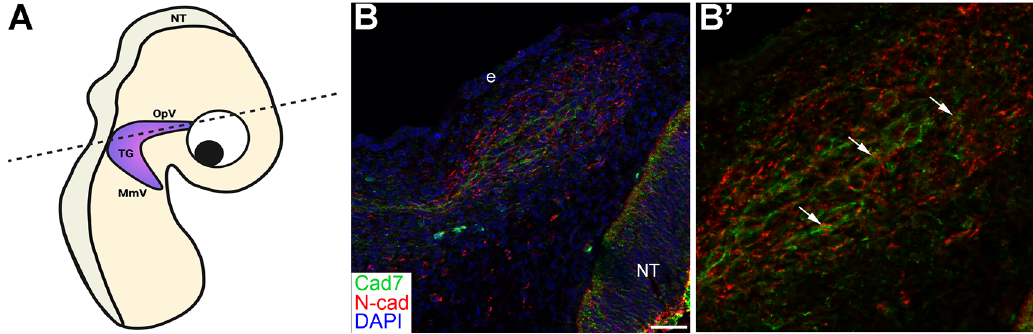
Figure 10. N-cadherin and Cadherin-7 are expressed in condensing placodal neurons and neural crest cells, respectively, during chick trigeminal ganglion assembly. (A) Cartoon diagram of forming TG in the developing chick embryo. Plane of section is shown by the dotted line. Diagram created with BioRender.com. (B) Representative transverse section taken through the forming TG followed by immunohistochemistry for Cad7 (green, marks neural crest cells) and N-cad (red, marks neurons which are all placode-derived at this stage). (C) Higher magnification (digital)oftheTGin(B).DAPI(blue),cellnuclei.Scalebarin(B)is100 μ mandappliesto(B ’ )butis50 μ m.N=5embryos. TG, trigeminal ganglion; Cad7, Cadherin-7; N-cad, neural cadherin; NT, neural tube; OpV, ophthalmic branch; MmV, maxillomandibular branch; e,